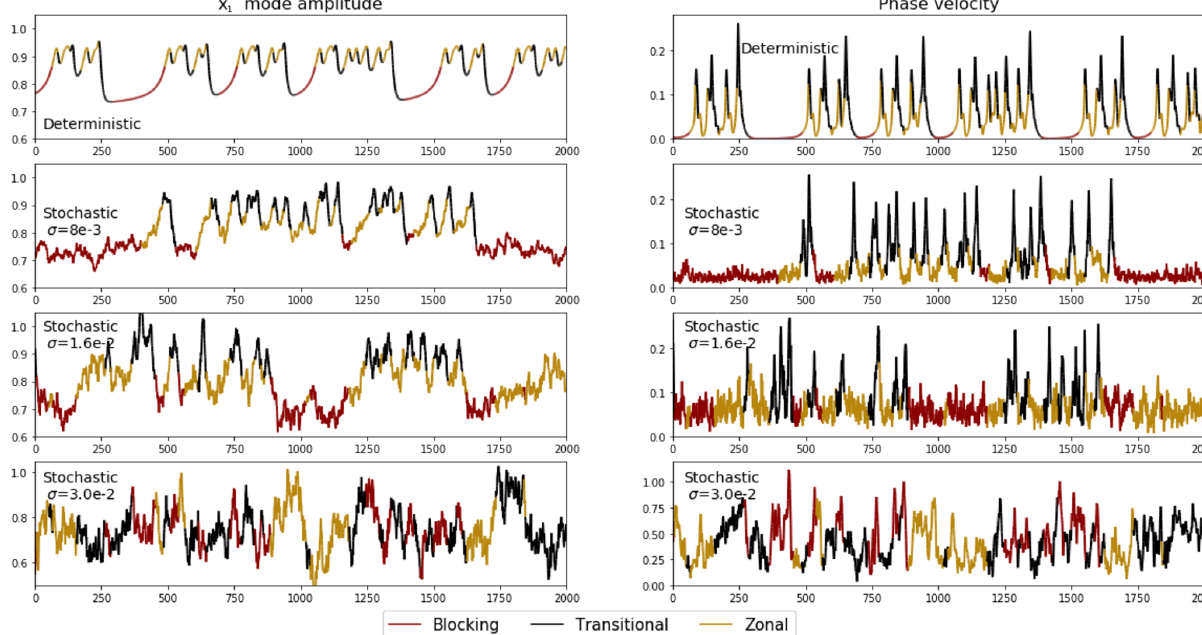
Figure 4. Left: time evolution of the x 1 mode in deterministic and stochastic cases, with points coloured by their regime assignment. Right: the corresponding phase